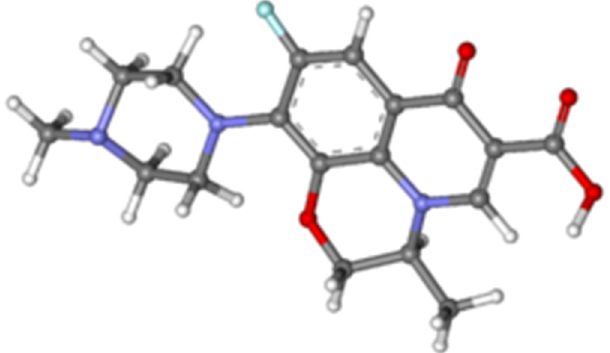
Figure 1. Chemical structure of levofloxacin drug. Nanomenclture: (-) -(S)-9-fluoro-2,3-dihydro- 3-methyl-10-(4-methyl-1-piperazinyl)-7-oxo-7H-pyrido[1,2,3-de]-1,4-benzoxazine-6-carboxylic acid hemihydrate. Carbon atoms (gray), hydrogen atoms (silver), oxygen atoms (red), nitrogen atoms (vilot), florine atom